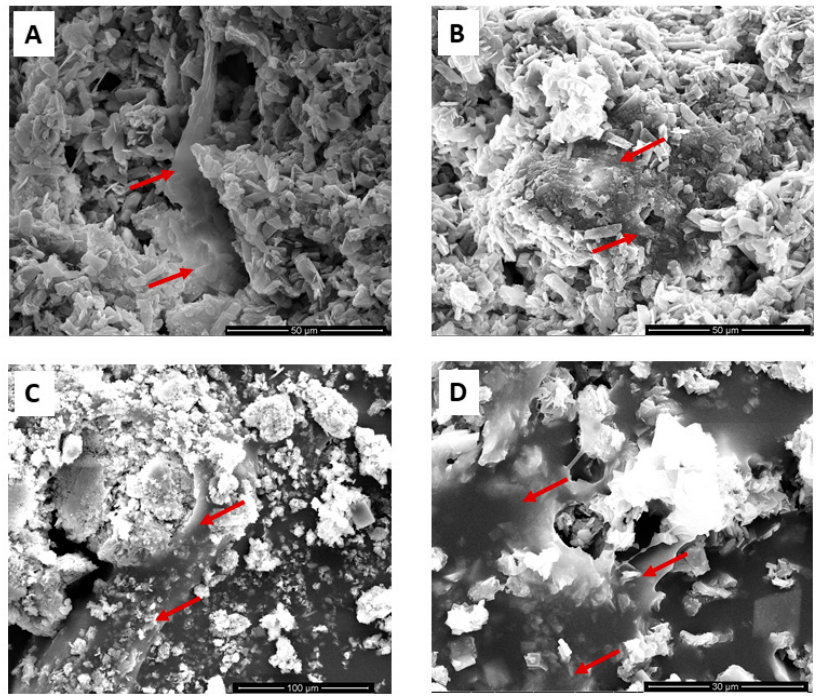
Figure 6. SEM analysis after three days of osteoblast culture onto ( A ) CaP alone, ( B ) CaP+Ale (1 μ M), ( C ) CaP+Dic (1 μ M), and ( D ) CaP+HR (75 μ M). Images are representative of three experiments. Red arrows indicate the presence of cells attached on material surfaces.